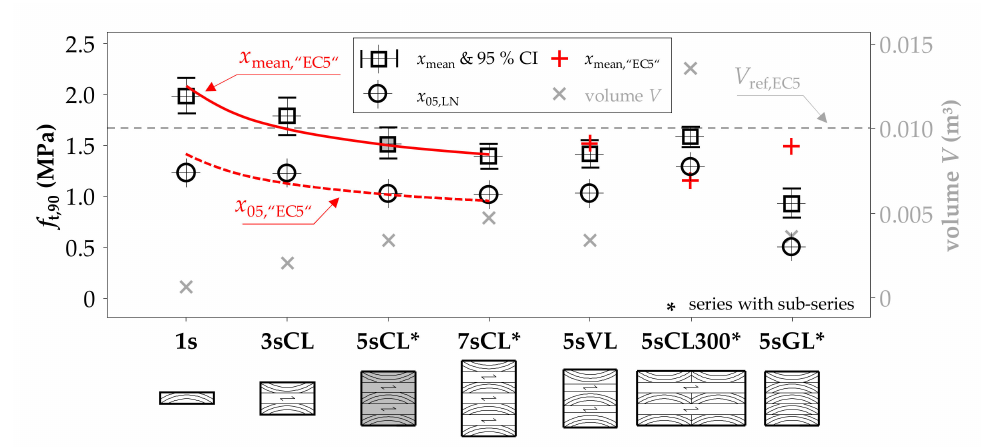
Figure 15. Tensile strength out-of-plane vs. number of layers and volume in comparison with the size effects power model for the tensile strength perpendicular to the grain in EC 5